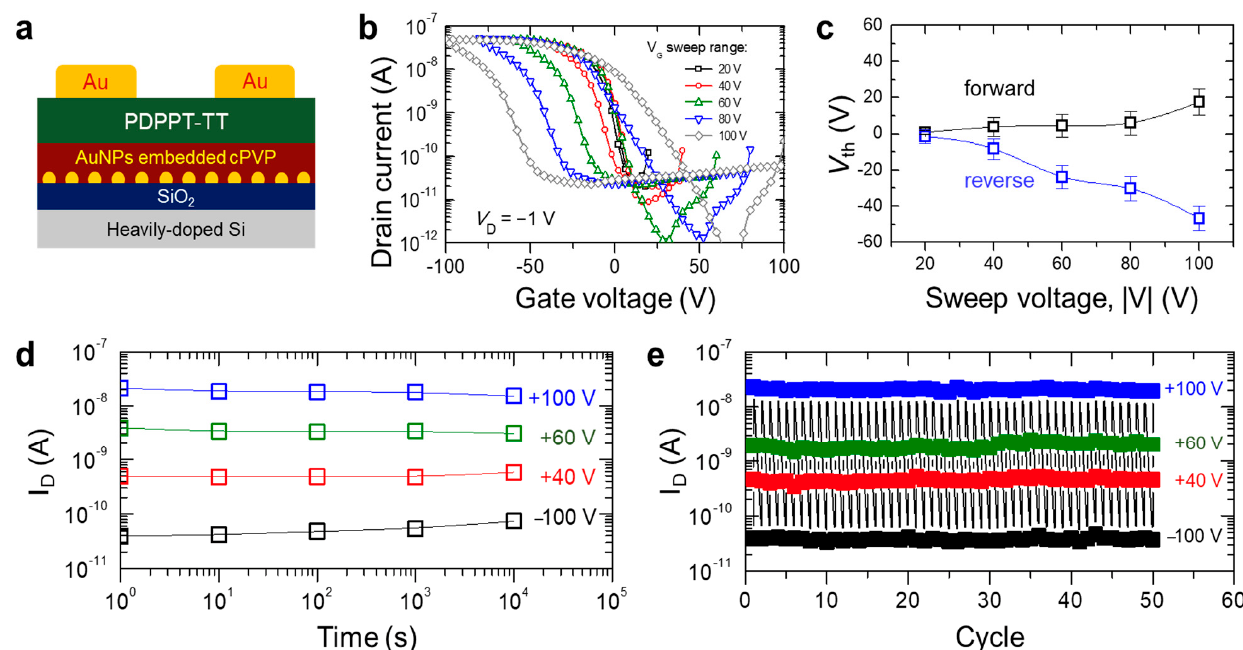
Figure 3. ( a ) Schematic of a non-volatile memory device by incorporating the AuNP-embedded c-PVP layer; ( b ) transfer characteristics of the memory device with respect to the gate voltage sweep range; ( c ) summarized plot of the memory windows defined as the threshold voltages of forward and reverse biases; ( d ) retention time of the device with different applied gate voltages; ( e ) cycling test of the device (the read voltage as V G = 0 V).